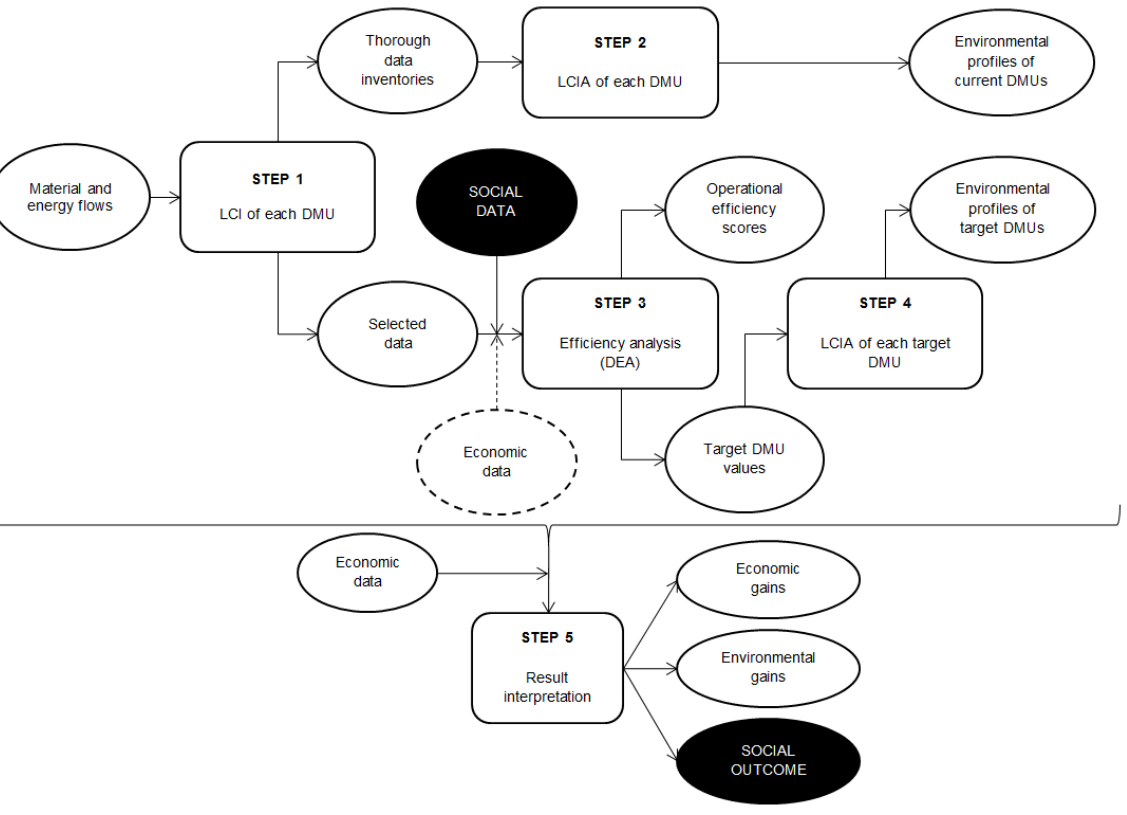
Figure 1. The integrative Life Cycle Assessment (LCA) + Data Envelopment Analysis (DEA) concept. Implementation of social elements into the traditional five-step LCA + DEA